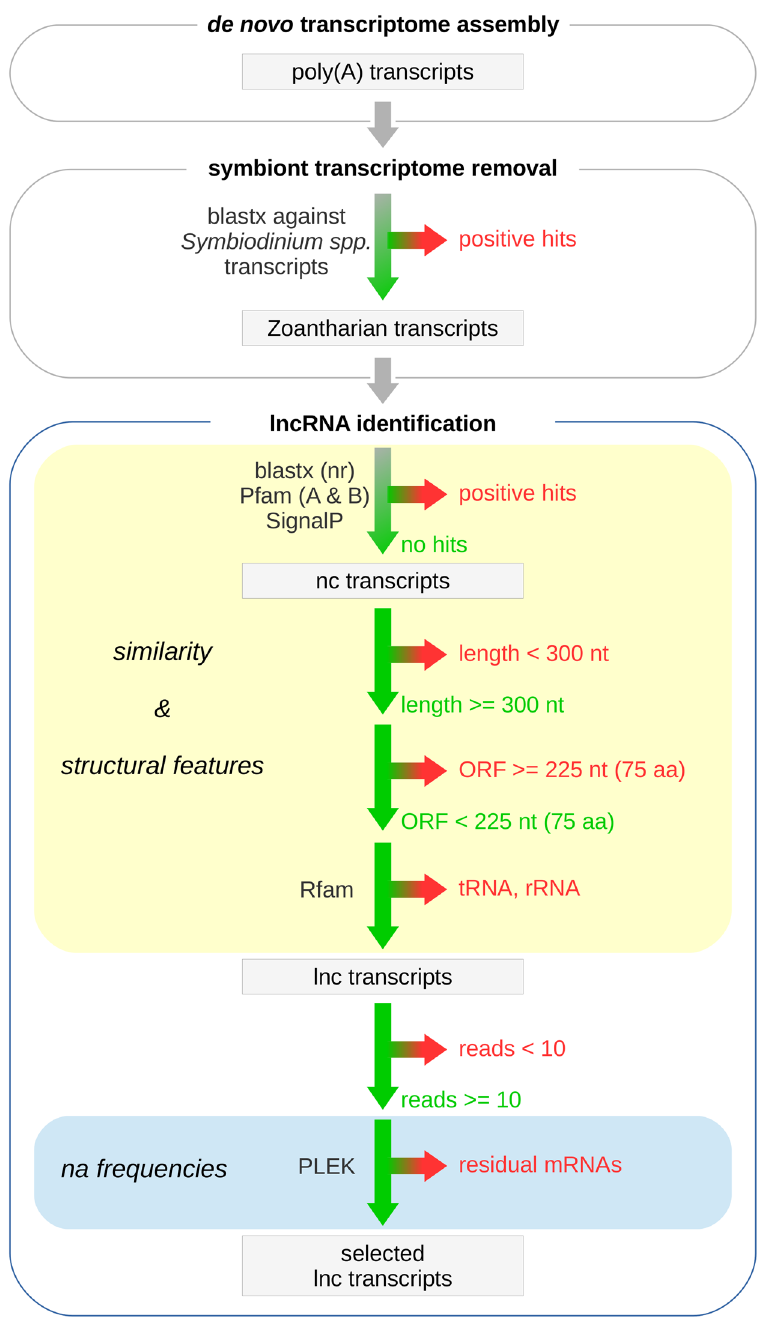
Figure 2. The filtering pipeline used for the identification of lncRNAs in the transcriptomes of Protopalythoa variabilis and Palythoa caribaeorum